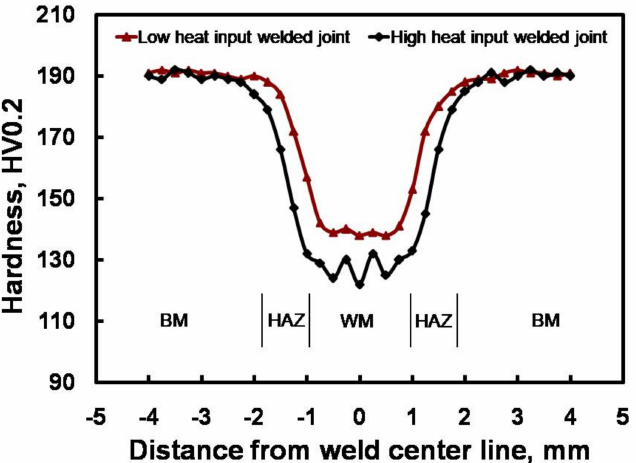
Figure 11. Hardness profiles of cross-sections of the low and high heat input